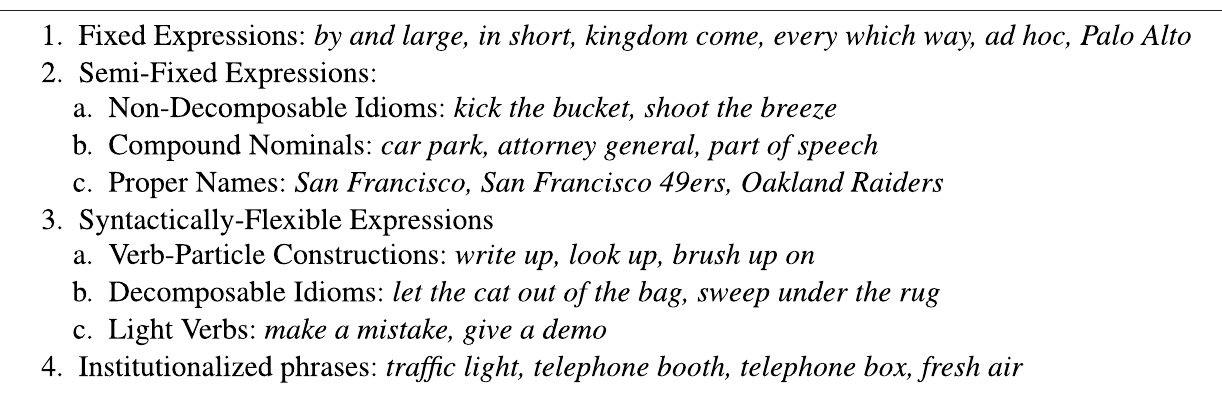
FIGURE 2 | Examples of Multiword Expressions (MWEs) from WordNet, MeSH and arXiv.